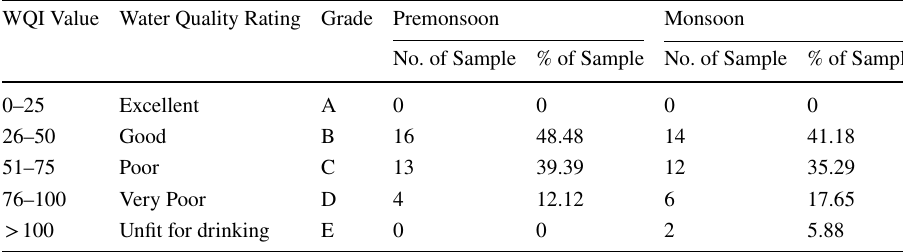
as per weight arithmetic water quality index method (Yogendra and Puttaiah 2008)